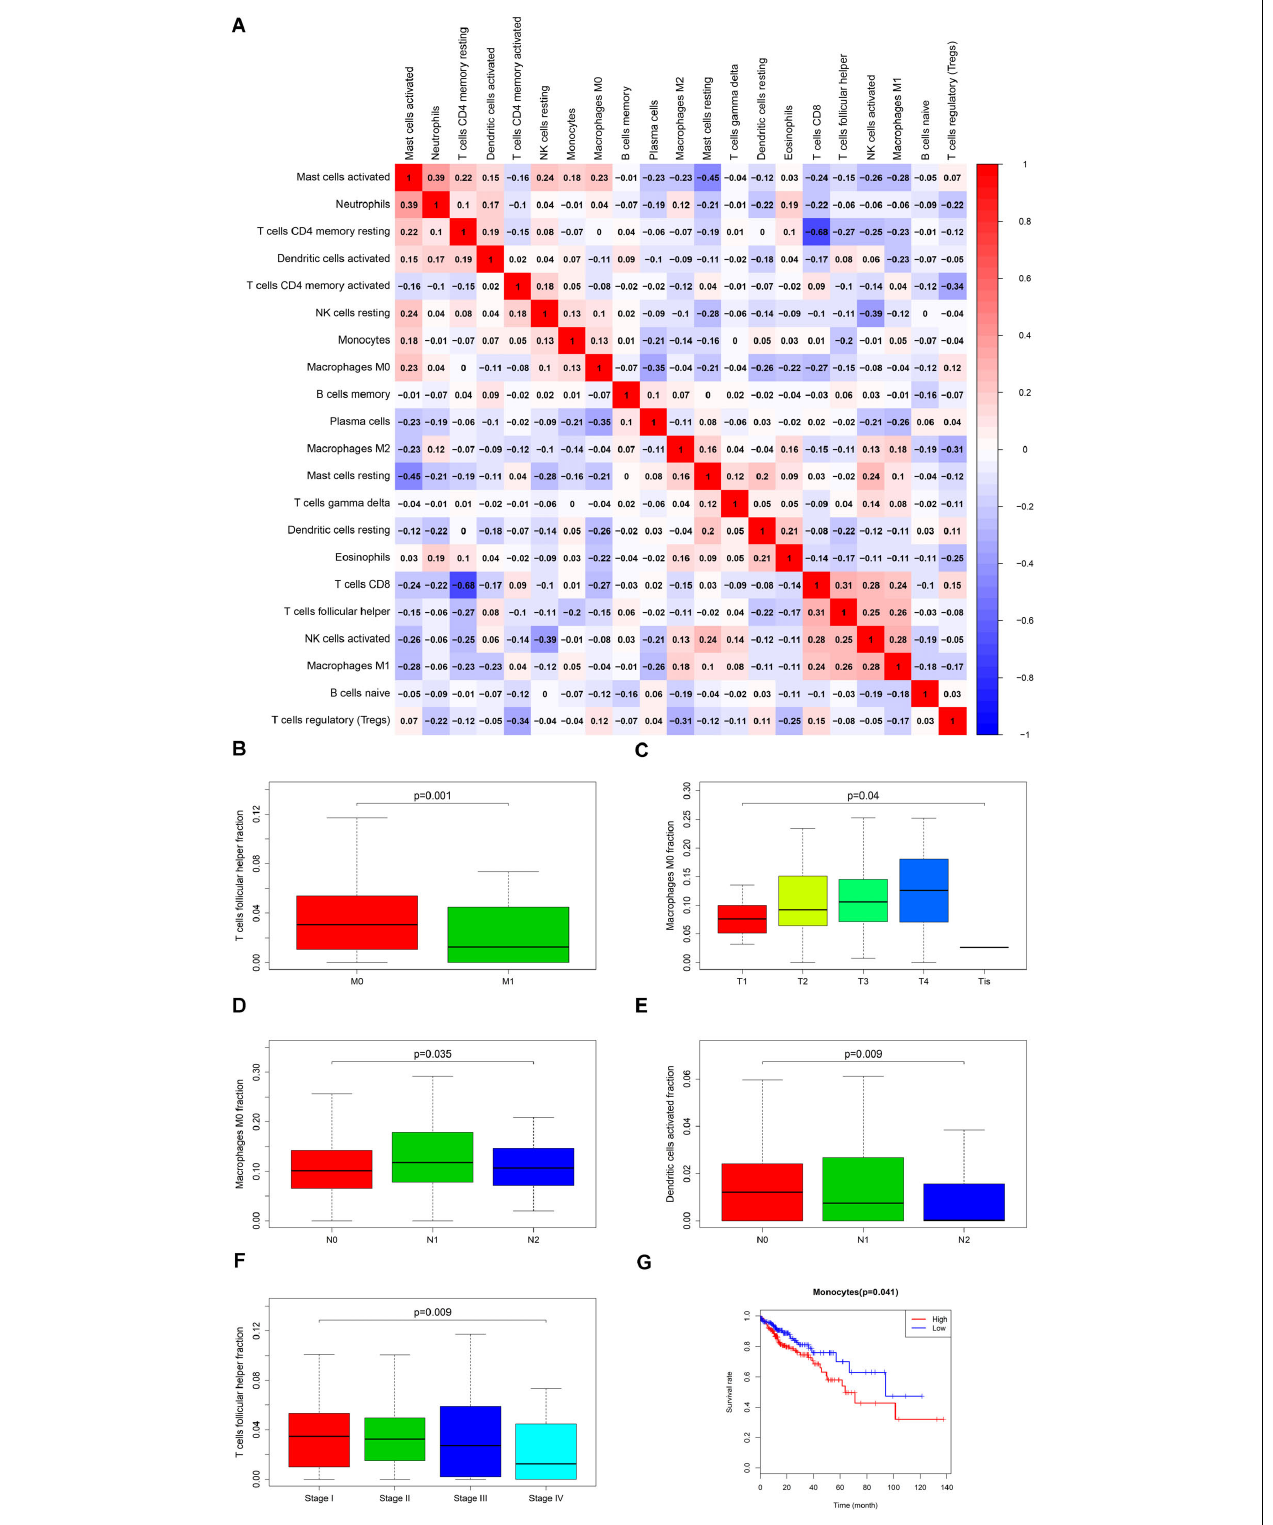
FIGURE 7 | The result of the co-expression analysis between significant immune cells (A) and the box plots about TMN stages of T cells follicular helper; Macrophages M0 and Dendritic cells activated (B–F) , and the result of the Kaplan-Meier curves of Monocyte (G) .